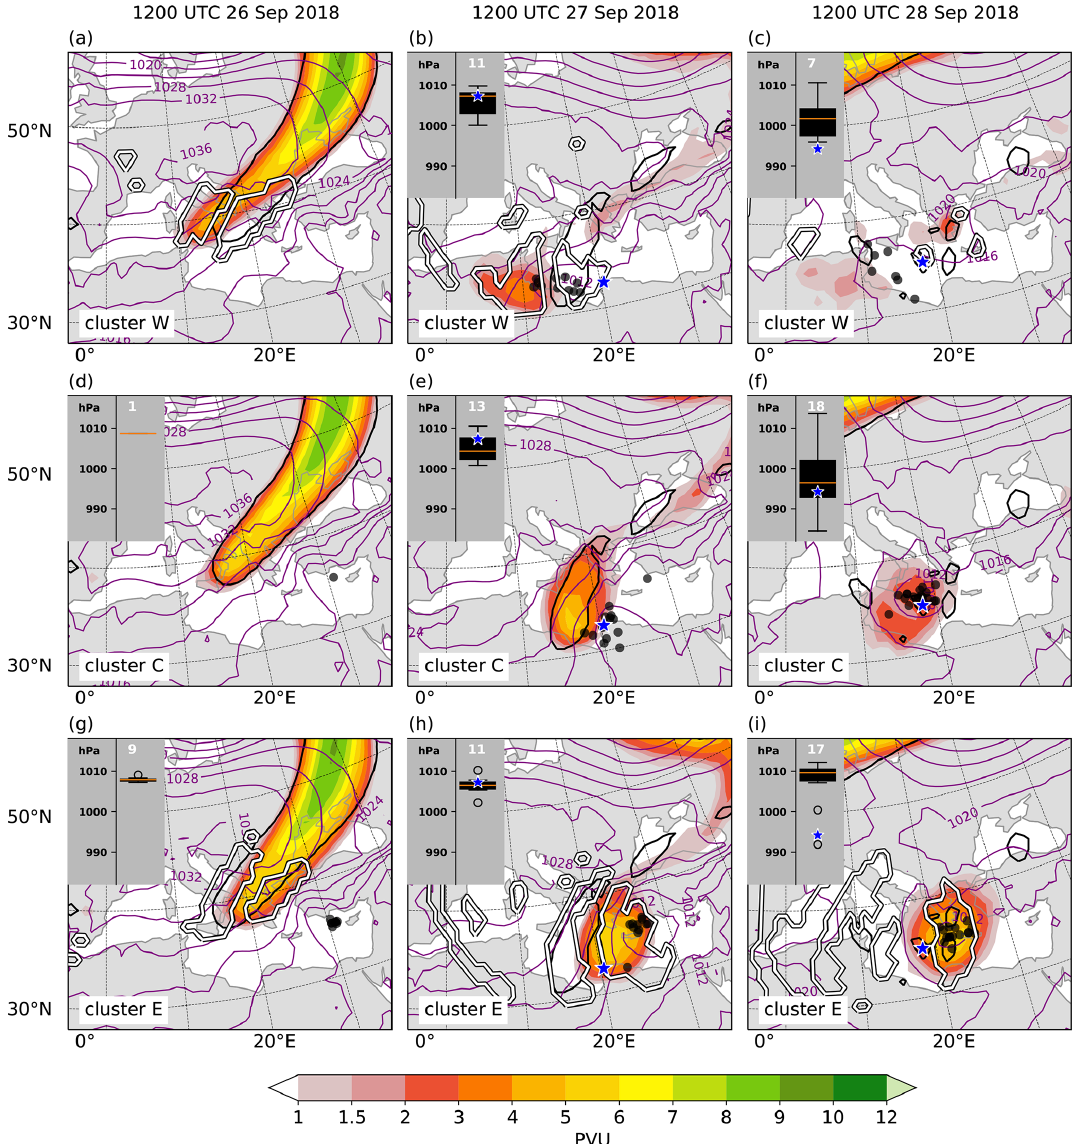
Figure 11. Cluster-mean PV at 325K (shaded, in PVU); cluster-mean sea level pressure (purple contours, every 4hPa); 2PVU analysis contour at 325K (black); cyclone positions (as identified with the method described in Sect. 2.3) in each ensemble member (black dots), and in the operational analysis (blue star) for clusters W, C, and E ( a–c , d–f , and g–i ) from 12:00UTC 26 September to 12:00UTC 28 Septem- ber 2018 every 24h. Insets at the top left of the panels show standard box plots (circles denote outliers) of minimum sea level pressure of the cyclones in each cluster and the value in the operational analysis (blue star); white numerals indicate the number of cyclones. Regions where the differences to cluster C of the PV field at 325K are statistically significant on the α fdr = 0 . 1 level are shown for clusters W and E as white contours ( a–c , g–i ; single isolated significant grid points are removed). The statistical significance for differences in sea level pressure are shown in Sect. S3 (Fig.